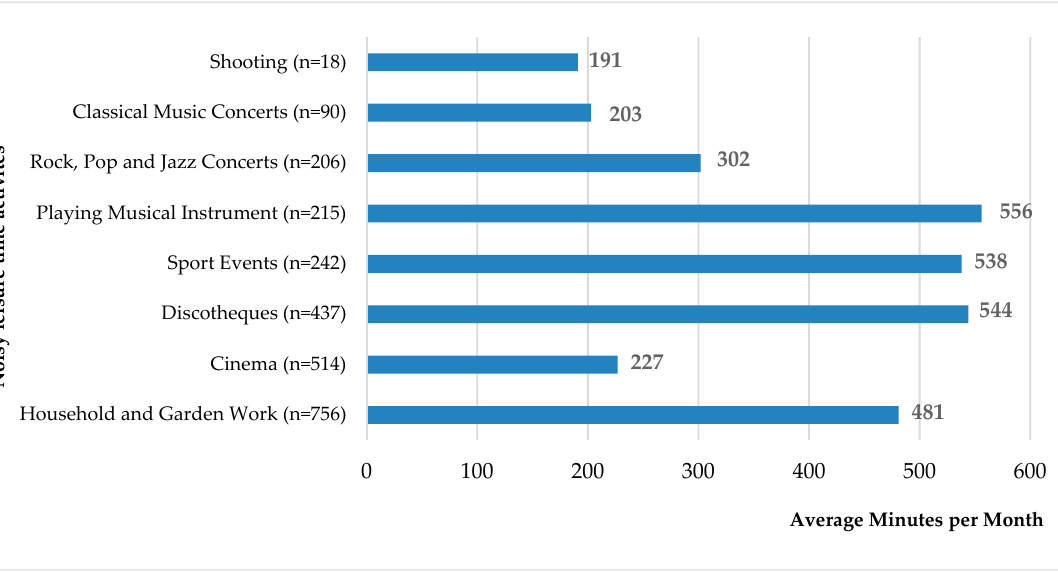
Figure 2. The number of students taking part in leisure time activities (average minutes per month).